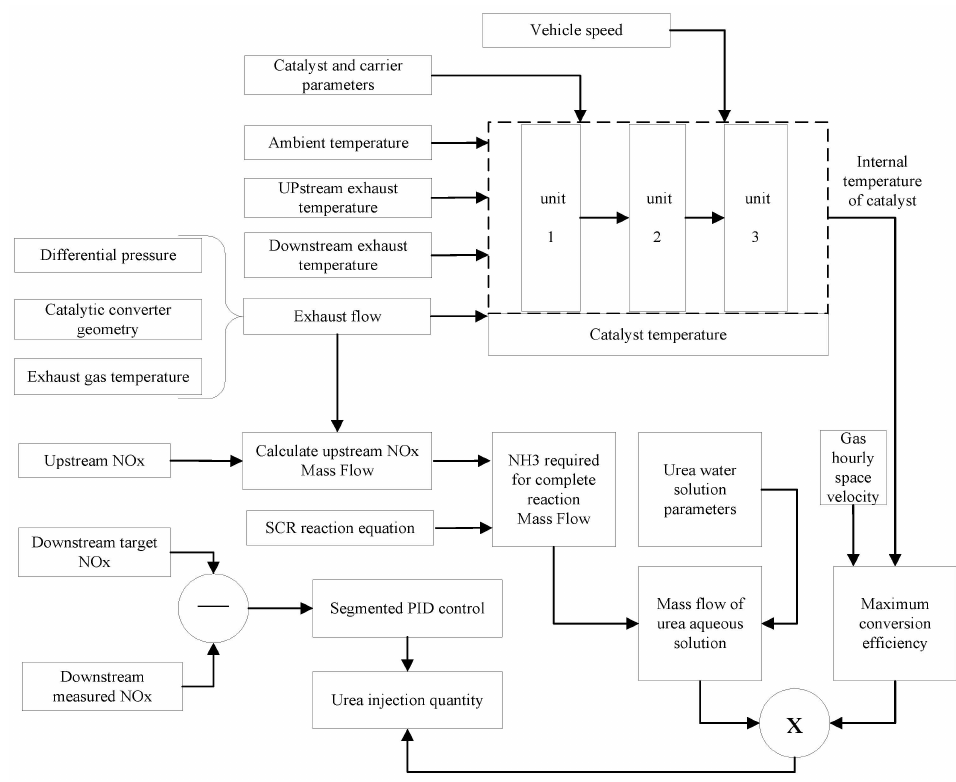
Figure 4. Scheme diagram of SCR system control